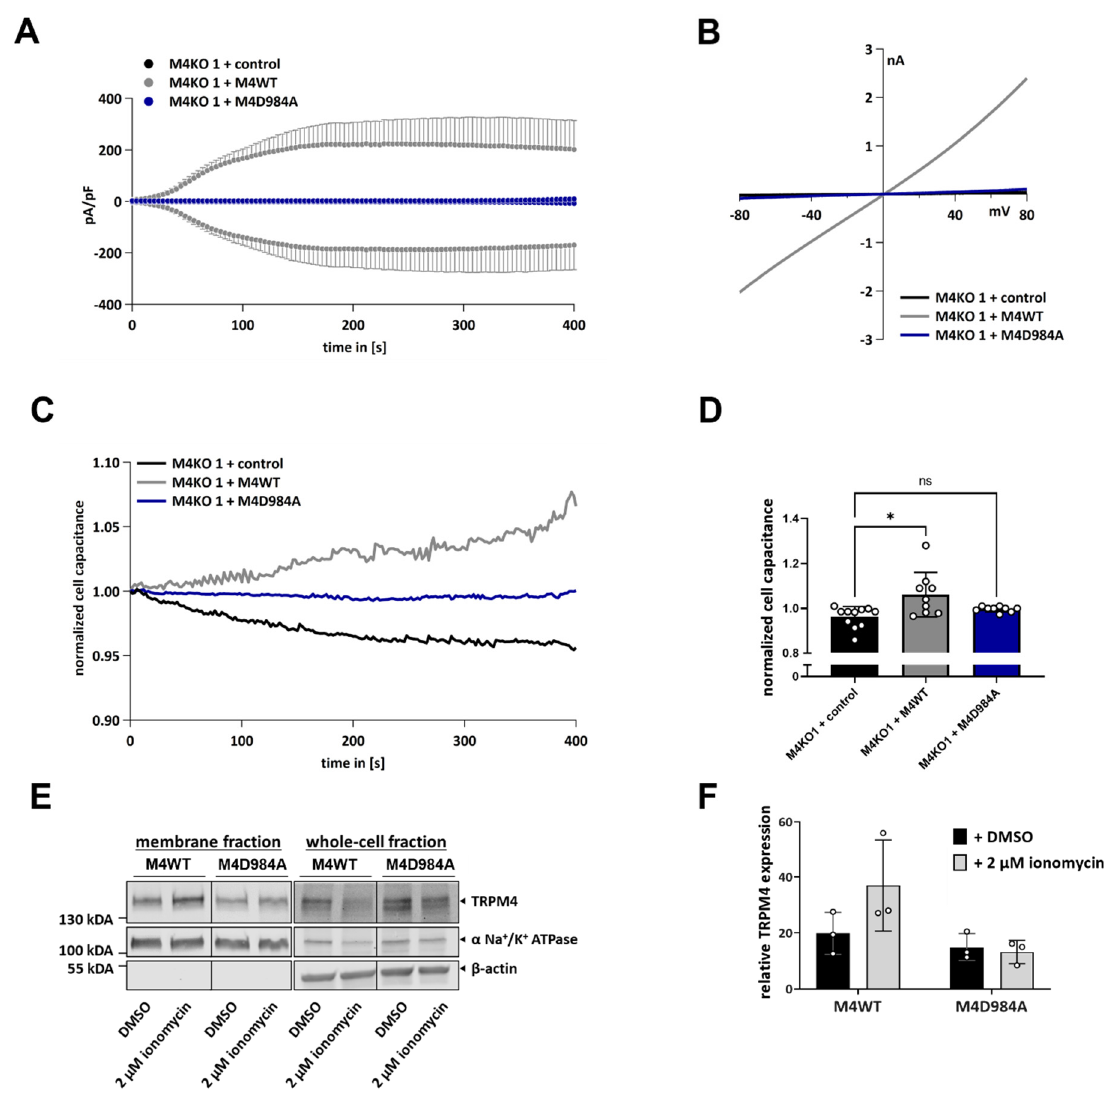
Figure 4. Analysis of M4KO 1 with expression of functional TRPM4 (M4WT) or dominant-negative TRPM4 mutant (M4D984A). ( A ) I CAN was evoked with 10 μ M Ca 2+ in the pipette ( n = 11 for M4KO 1 + control, n = 9 for M4KO 1 + M4WT, n = 9 for M4KO 1 + M4D984A). ( B ) Corresponding IVs at 394 s from cells in (A). ( C ) Normalized cell capacitance from cells in (A) after activation with 10 μ M Ca 2+ cell capacitance was plotted versus time ( n = 12 for M4KO 1 + control, n = 9 for M4KO 1 + M4WT, and n = 9 for M4KO 1 + M4D984A). ( D ) Bar diagram of data in ( C ) at 394 s. Kruskal–Wallis test for